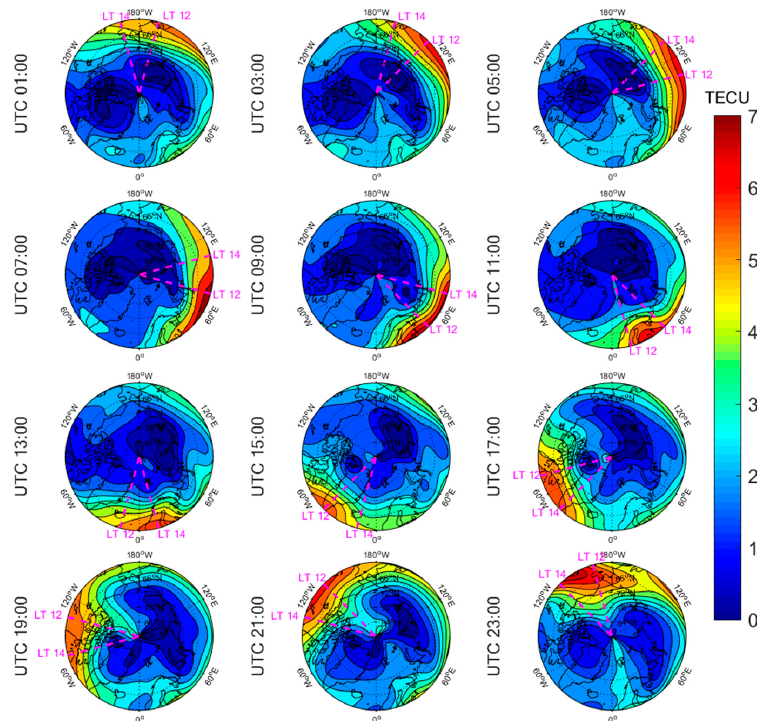
Figure 5. Spatial distribution of mapping TEC of 12 sections under low solar activity year, polar night (DOY 001 in 2010) over the Arctic. The magenta lines in each subplot represent the longitudes at 12:00 and 14:00 at the middle of the 2 h section of the corresponding subplot.